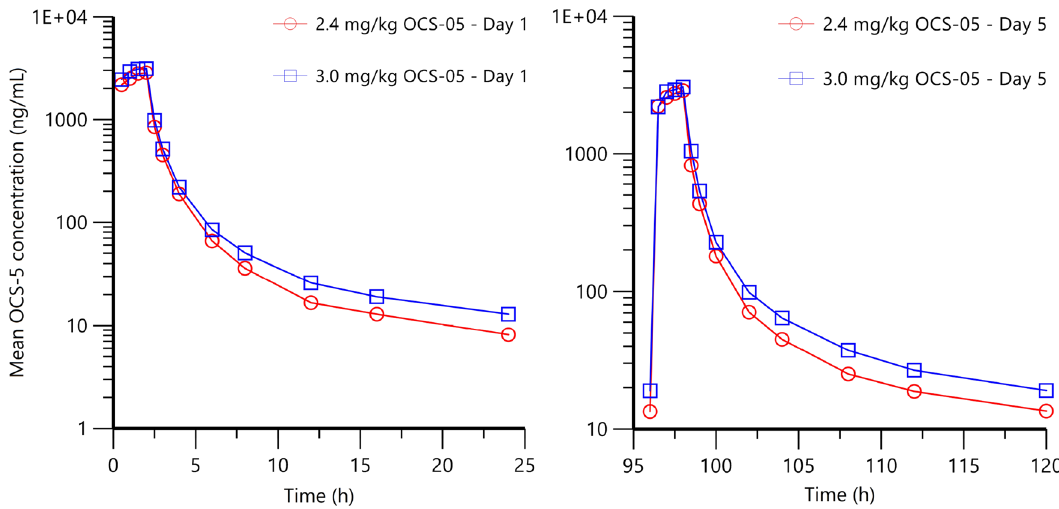
Figure 2. Summary of Derived Pharmacokinetic Parameters Following Multiple Dose Administration of OCS- 05 (I.V. Infusion) to Healthy Male and female Subjects. Geometric Mean